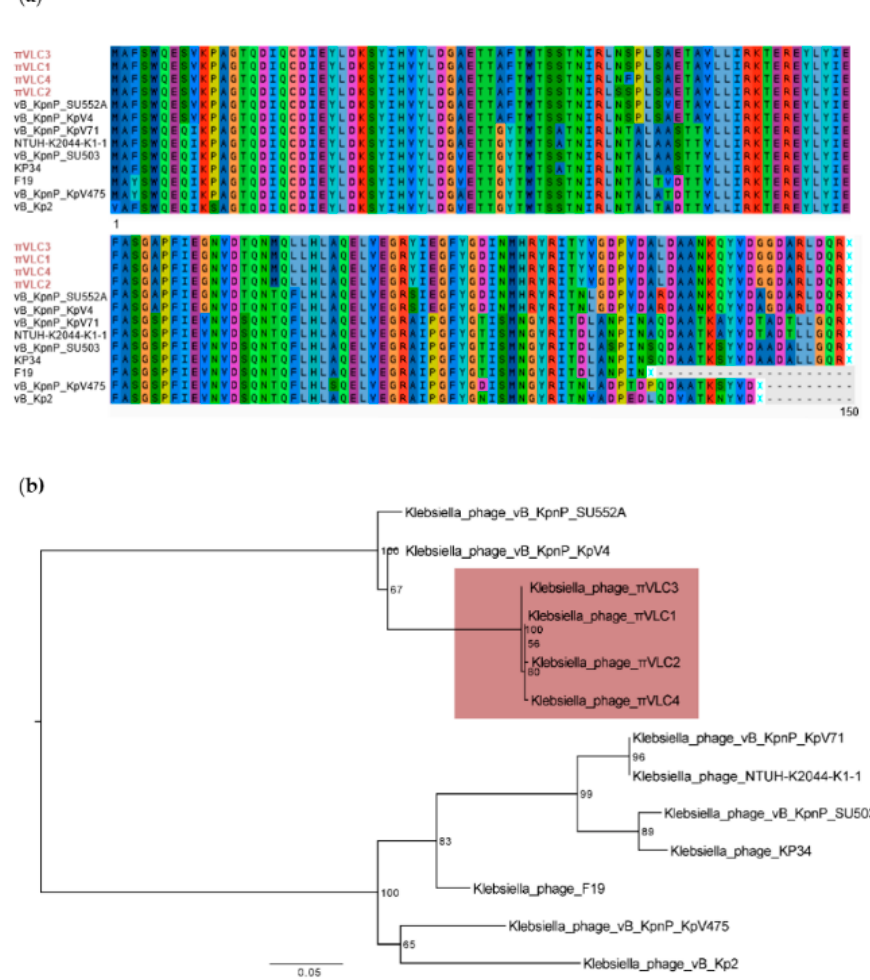
Figure 5. Tail fiber conserved domain alignment and phylogenetic relationships in the genus Drulisvirus . ( a ) Amino acid multiple sequence alignment of the conserved tail fiber protein domain. The four phages isolated and characterized here are indicated in red. Colors in the figure represent different amino acids. ( b ) Nucleotide maximum likelihood tree of the conserved tail fiber protein domain of the genus Drulisvirus. Numbers indicate bootstrap values (1000 pseudo-replicates). The four phages isolated and characterized here are indicated in red.